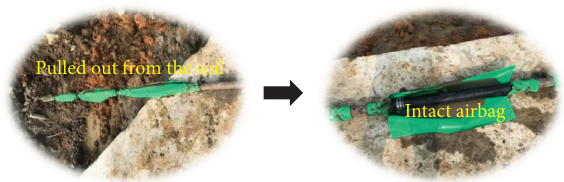
Figure 16: The stressed airbag in the formation.